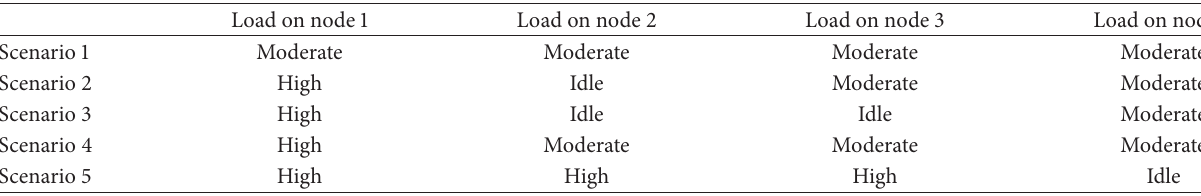
Table 2: Workload scenarios.